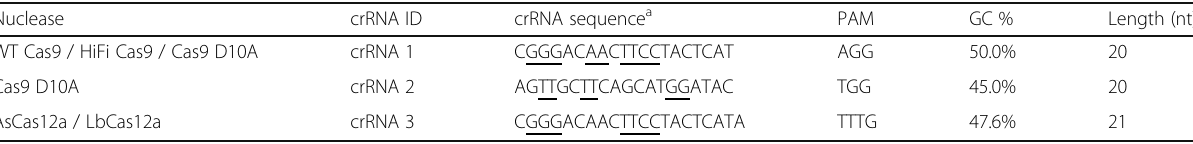
Table 1 crRNA and enzymes used in the experiment